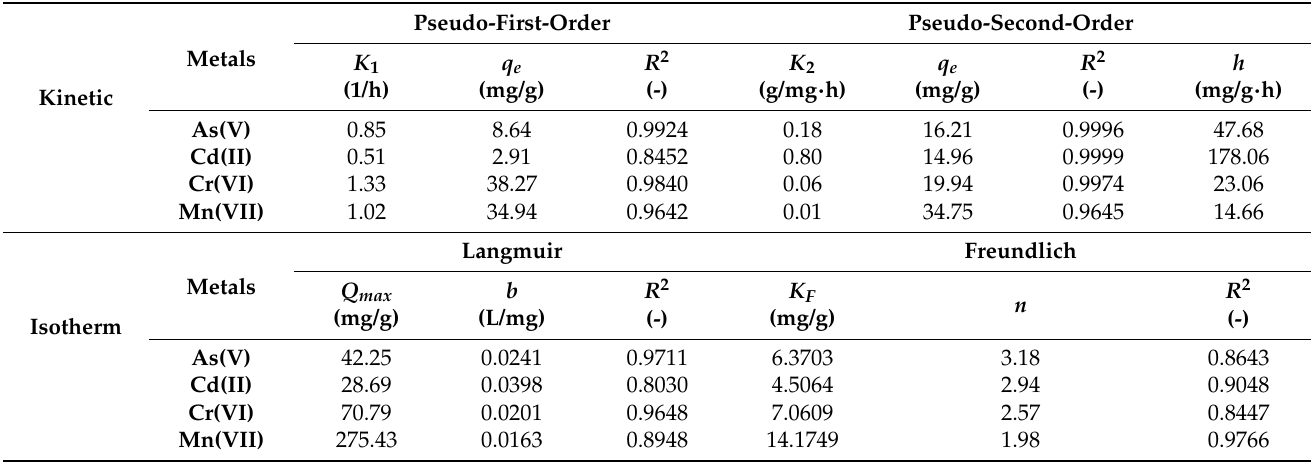
Figure 2. Kinetics of metalloid/metal adsorption (As(V), Cd(II), Cr(VI), and Mn(VII)) onto the sludge–chitosan (biomass dosage = 2 g/L, agitation rate = 200 rpm, contact time = 6 h, temperature = 25 °C, Vw = 200 mL, and pH non shift (pH 5.5)). Table 3. Kinetic and isotherm constants for the biosorption of As(V), Cd(II), Cr(VI), and Mn(VII) by RCA.